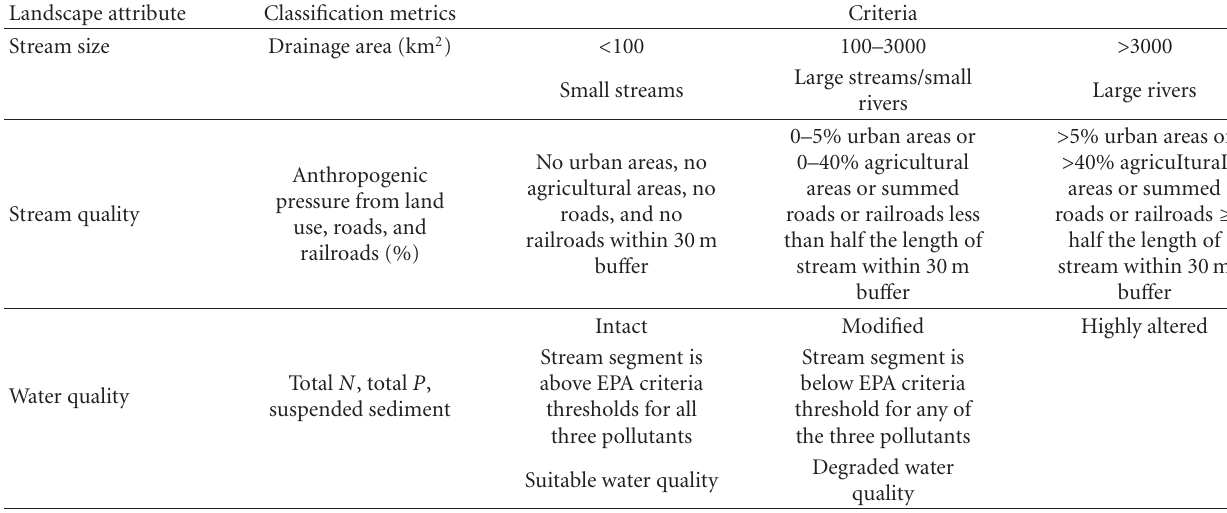
Table 1: Landscape attribute classification